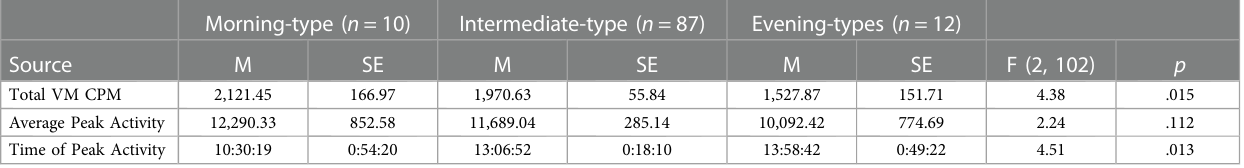
TABLE 5 Chronotype group differences in total activity, peak activity, and time of peak activity ( N